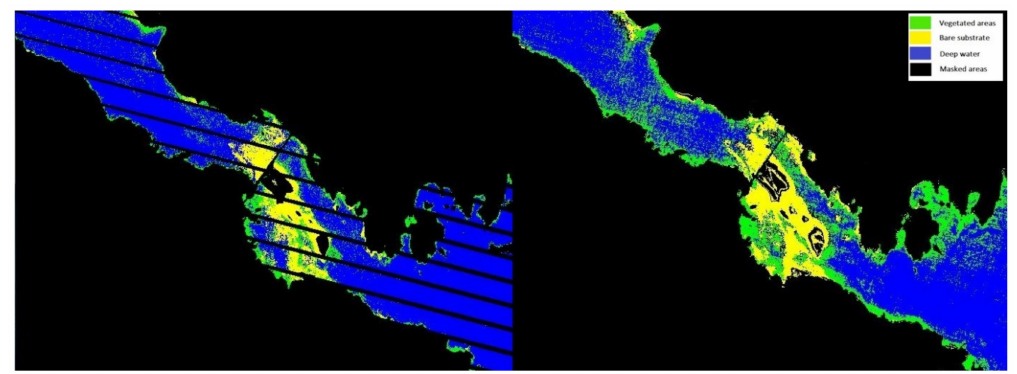
Figure 4. Landsat 7 image (on the left) from 19th June 2007 represents minimum vegetated area values in Small Strait. Landsat 5 image (on the right) from 27th July 1986 represents maximum vegetated area values.